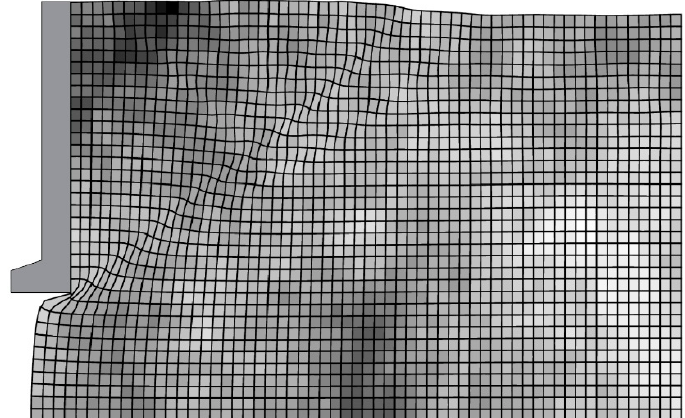
φ of Example #2 ( H θ = 4.2; see Table 1).